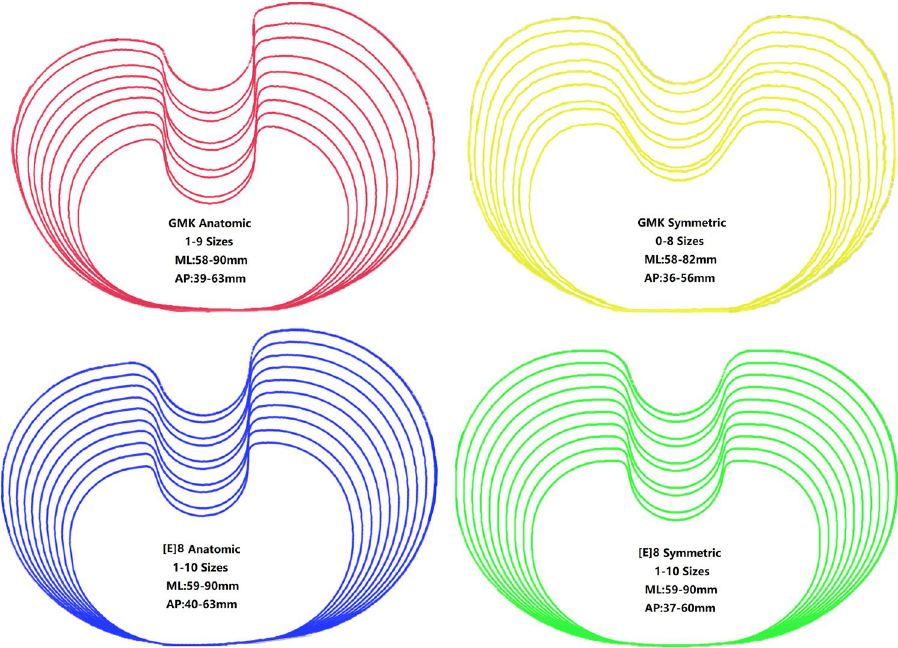
Figure 2. The four tibial baseplate designs, their associated sizing distribution and geometric